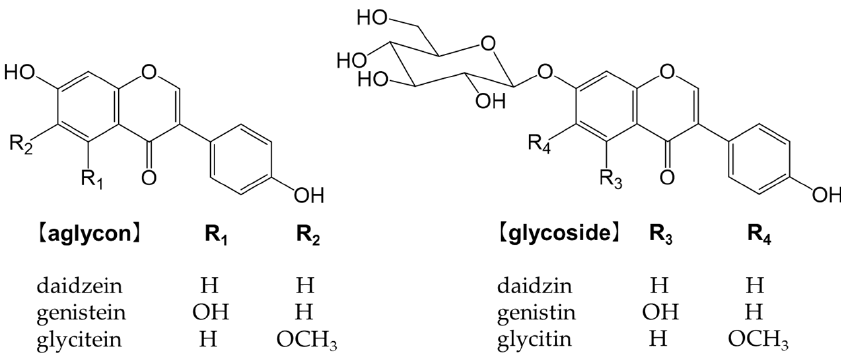
Figure 8. Chemical structure of the main isoflavones and isoflavone glycosides.